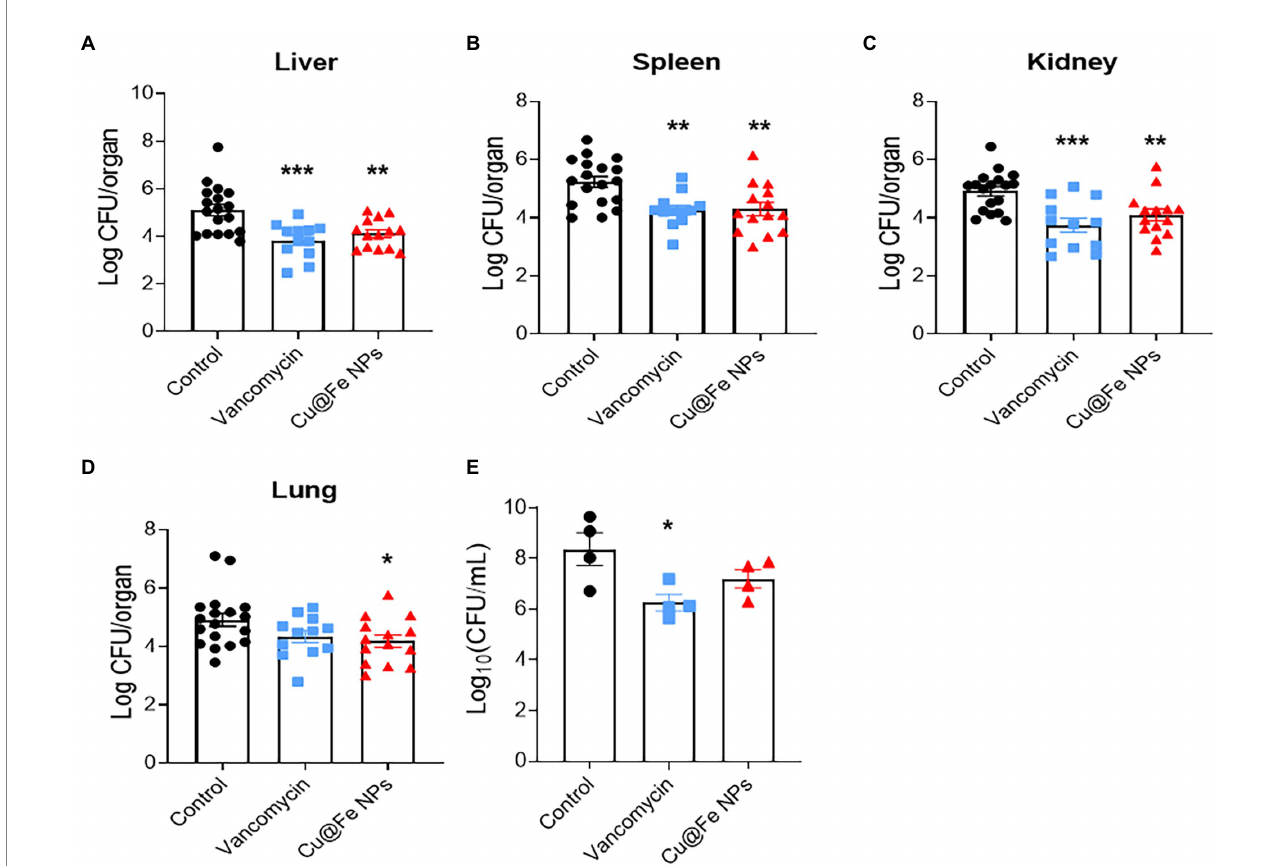
FIGURE 5 In vivo validation for the antibacterial effects of Cu@Fe NPs on MRSA-induced systemic infection and skin wound infection models. (A–D) Effects of treatment with 7.8 mg/kg Cu@Fe NPs on the bacterial burden in the liver (A) , spleen (B) , kidney (C) , and lung (D) of MRSA-infected mice, respectively. There was a significant decrease in organ CFU in the mice treated with vancomycin or Cu@Fe NPs compared to the untreated group. Control and Cu@Fe NPs groups, n = 10. Vancomycin group, n = 8. (E) CFU status of the infected skin flaps in mice, n = 4. CFU counts for the homogenized tissue collected from each mouse were performed in replicates. (A–D) Control, n = 18. Vancomycin, n = 12. Cu@Fe NPs, n = 14. Data are from three independent experiments. (E) n = 4. Data are from two independent experiments. (A–E) One-way ANOVA with Dunnett’s mulitple comparisons test. Data are expressed as mean ± SEM versus controls group, * p < 0.05; ** p < 0.01; and *** p <